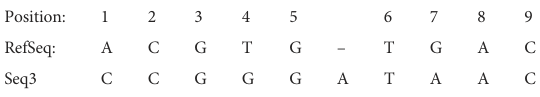
The distribution of 12 SNP types in different countries is analyze. The 11897 sequences are distributed in 78 countries, as listed in Supplementary Table S1. To better exhibit the quantitative distribution of HIV-1 genome, we plot them in Figure 3. There are many HIV-1 cases in the Atlantic coastal countries, and the transmission may be related to traf fi c and living environment. The top 20 countries with larger number of genome include South Africa, which has the largest population of people with HIV of any country in the world (Ritchie and Max, 2018); South and South East Asia (For example, Thailand), which is the second most affected (UNAIDS, ); United States, where over 675 thousand people died of AIDS since the beginning of the HIV epidemic (Prevention, C.f.D.C.a,